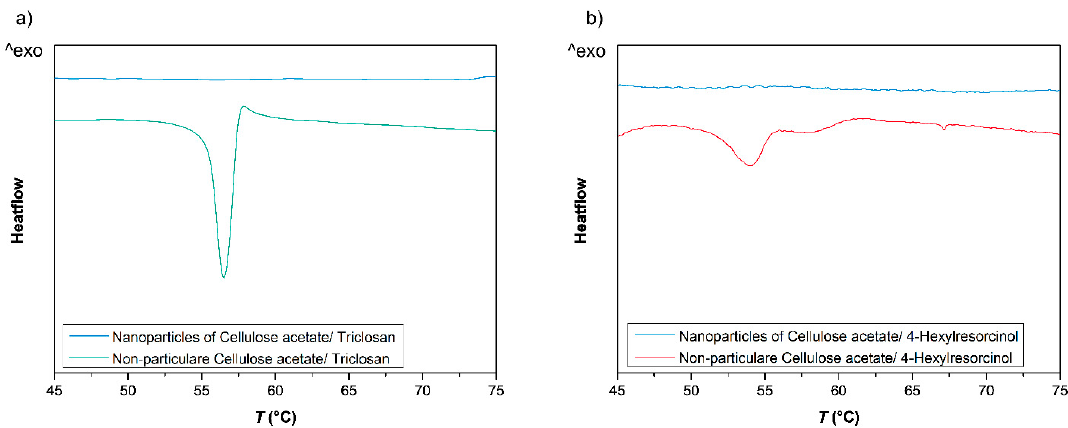
Figure 7. DSC measurement of cellulose acetate nanoparticles (blue) containing 0.2 g Triclosan / g cellulose acetate ( a ) or 4-Hexylresorcinol respectively ( b ) and non-particular cellulose acetate / Triclosan mixtures with identical Triclosan / cellulose acetate ratio (a, green) or 4-Hexylresorcinol / cellulose acetate mixtures (b, red).